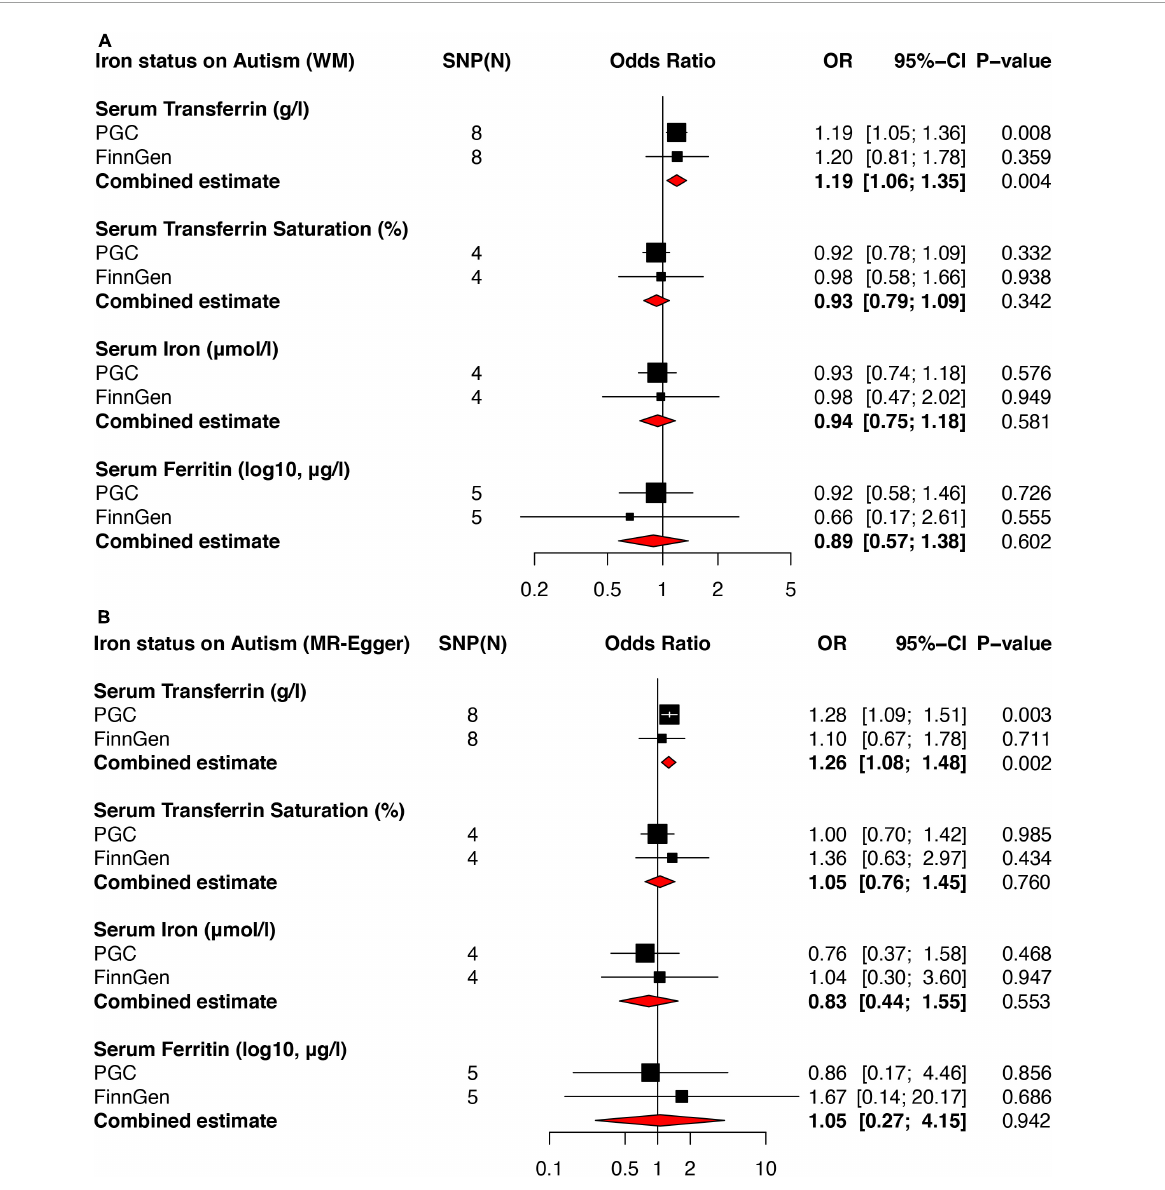
FIGURE3 Forest plots of MR analyses showing the causal effects of iron status on autism using weighted median and MR Egger method. Two independent autism GWAS datasets from PGC and FinnGen Consortium were used to evaluate the causal effect. The combined estimates were presented as red diamonds. (A) Showed the causal effect of iron status on autism using the weighted median method. (B) Showed the causal effect of iron status on autism using the MR Egger method. PGC, psychiatric genomics consortium; WM, weighted median; MR, Mendelian